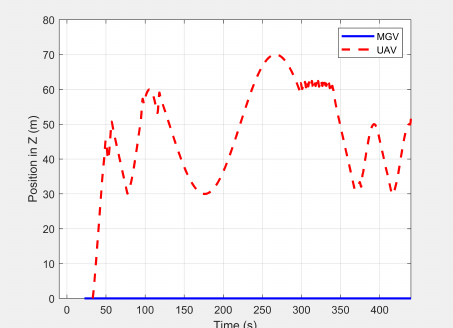
Figure 22. Variation in the altitude of the UAV’s planned path with time when following the MGV while moving at varying velocities in the presence of static